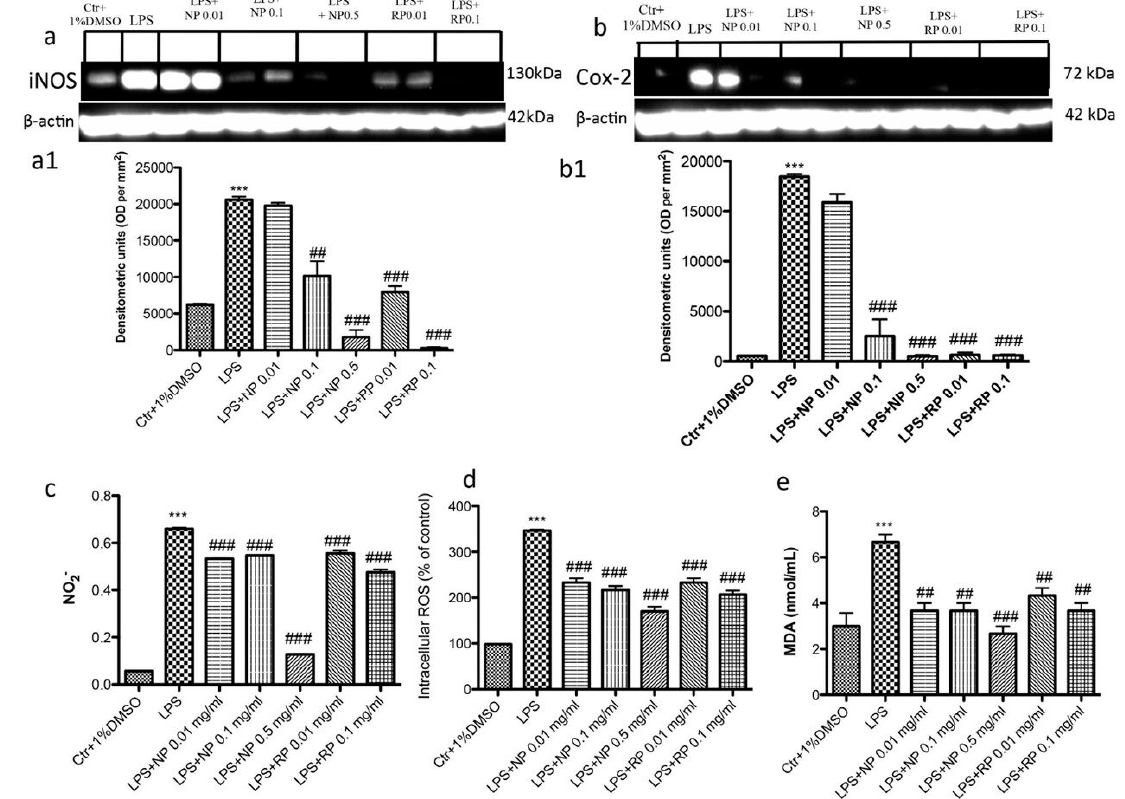
Figure 4. Effect of NP and RP on the expression of iNOS, COX-2 and nitrite levels. Western blot analysis for iNOS and COX-2 demonstrated a significant increased levels after LPS stimulation ( a , b ); treatments with NP only at concentrations of 0.1 and 0.5 mg/mL and RP at 0.01 and 0.1 mg/mL significantly reduced iNOS expressions. No protection was observed with NP 0.01 mg/mL. The levels of COX-2 were also reduced with NP treatment at concentrations of 0.1 and 0.5 mg/mL and RP at 0.01 and 0.1 mg/mL. Less protection, but significant, was observed with NP 0.01 mg/mL. Moreover, we analyzed the levels of nitrite production and we observed an increase of nitrite levels after LPS stimulation ( c ), whereas treatments with NP, only at 0.5 mg/mL, significantly reduced nitrite production. Moreover, we determinate the levels of ROS content and MDA production ( d , e ), and observed an increase of ROS content and MDA levels after LPS stimulation, whereas treatments with NP and RP reduced ROS and MDA levels at concentration dependent manner. Data are representative of at least three independent experiments; *** p < 0.001 vs. Ctr; ### p < 0.001 vs. LPS; ## p < 0.01 vs. LPS.